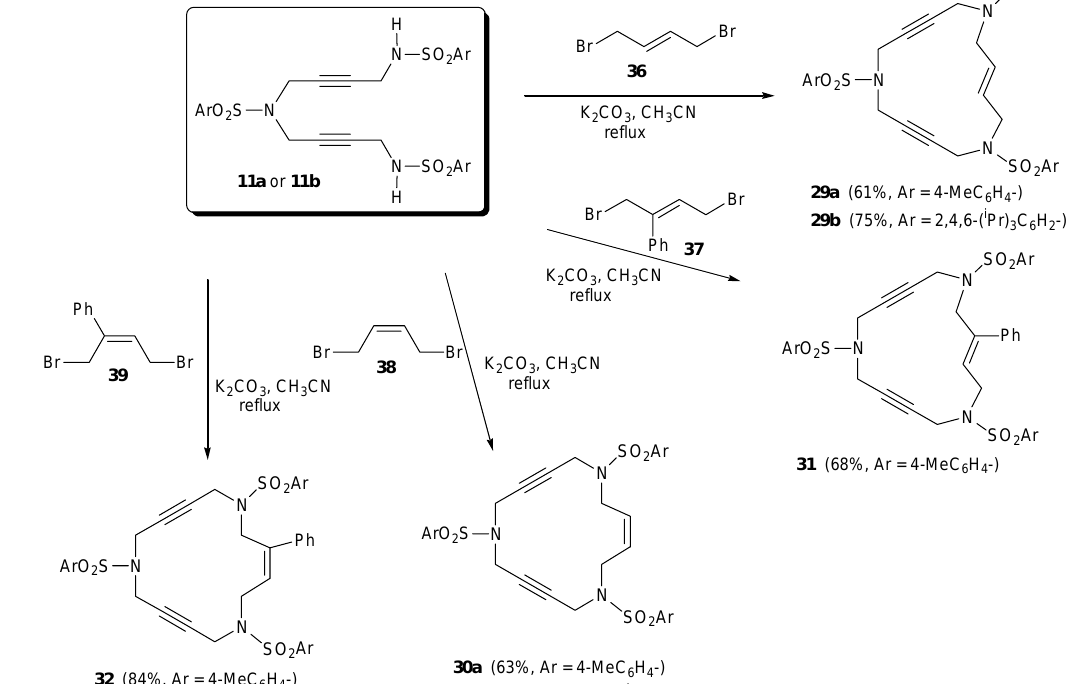
Scheme 7. Synthesis of 15-membered enediyne macrocycles 29 - 32